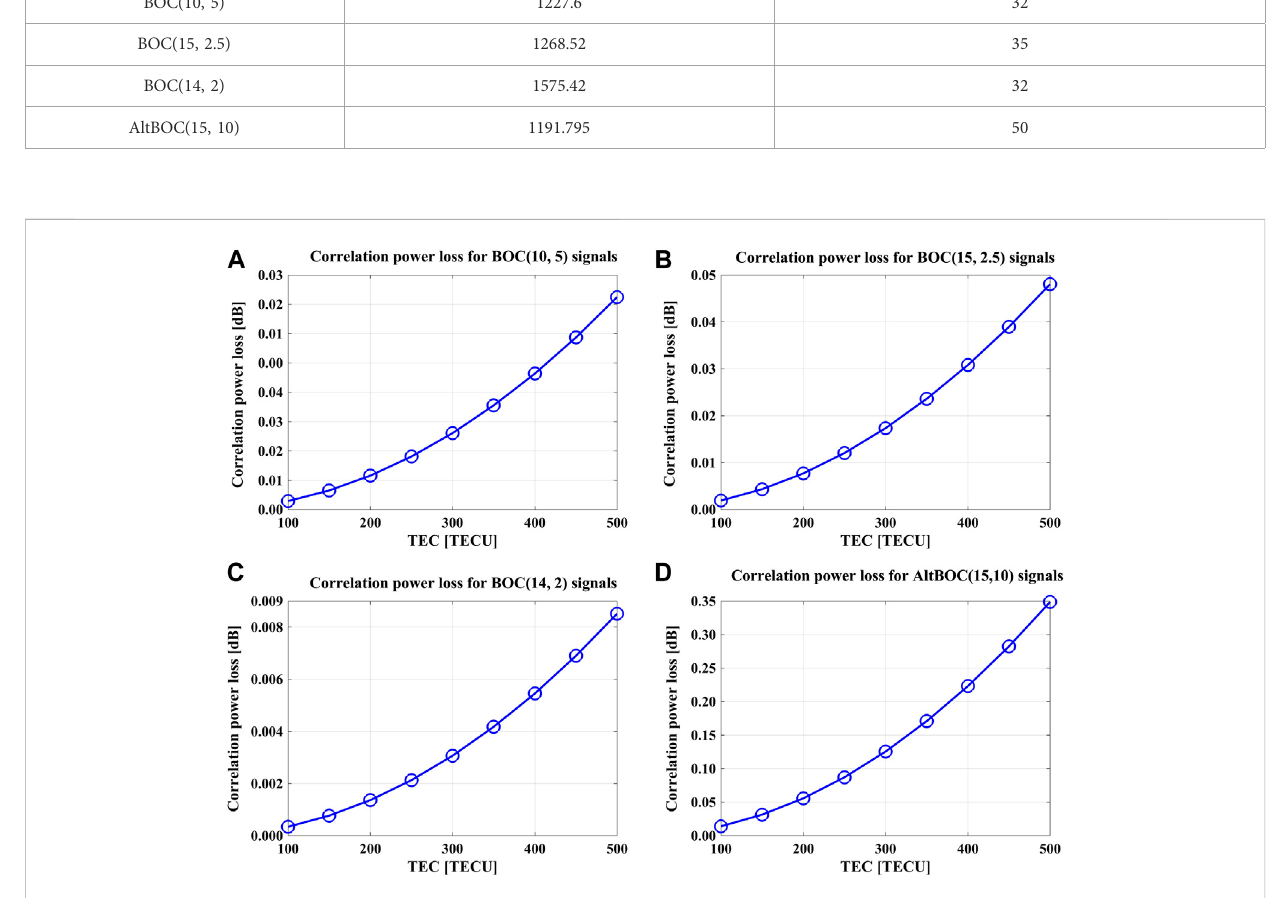
FIGURE 5 Power loss of the correlation peaks for different TEC